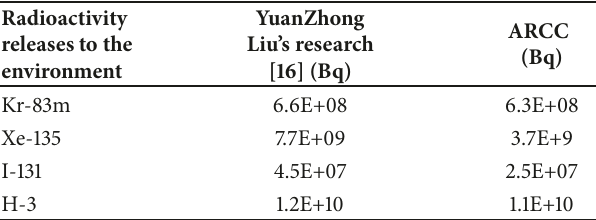
Table 6: The comparison of YuanZhong Liu’s research and ARCC calculation results of the LOCA accident.